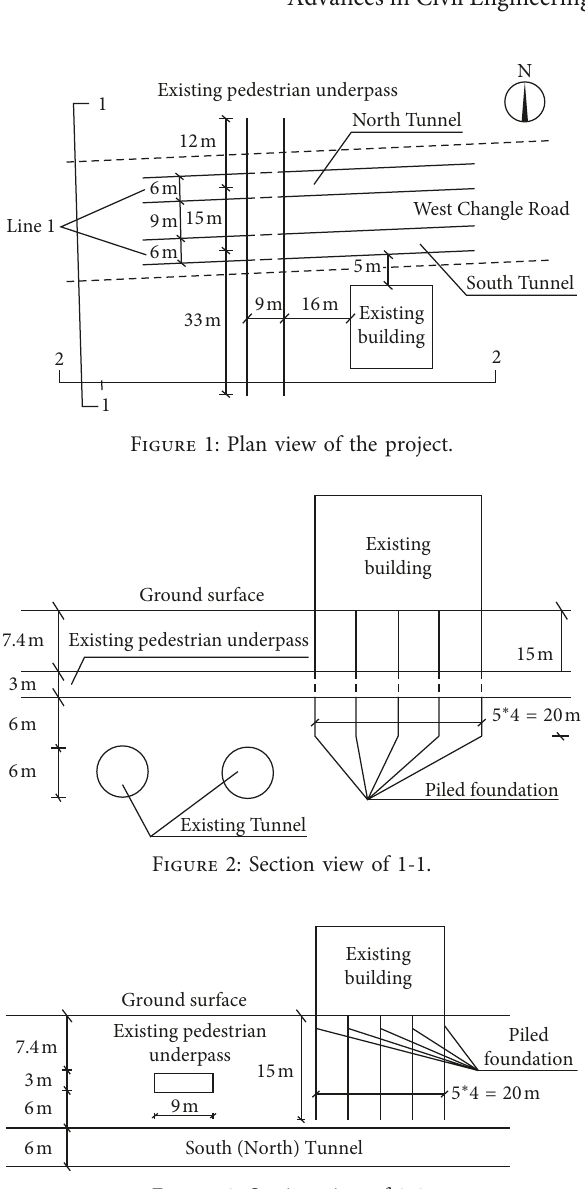
Figure 3: Section view of